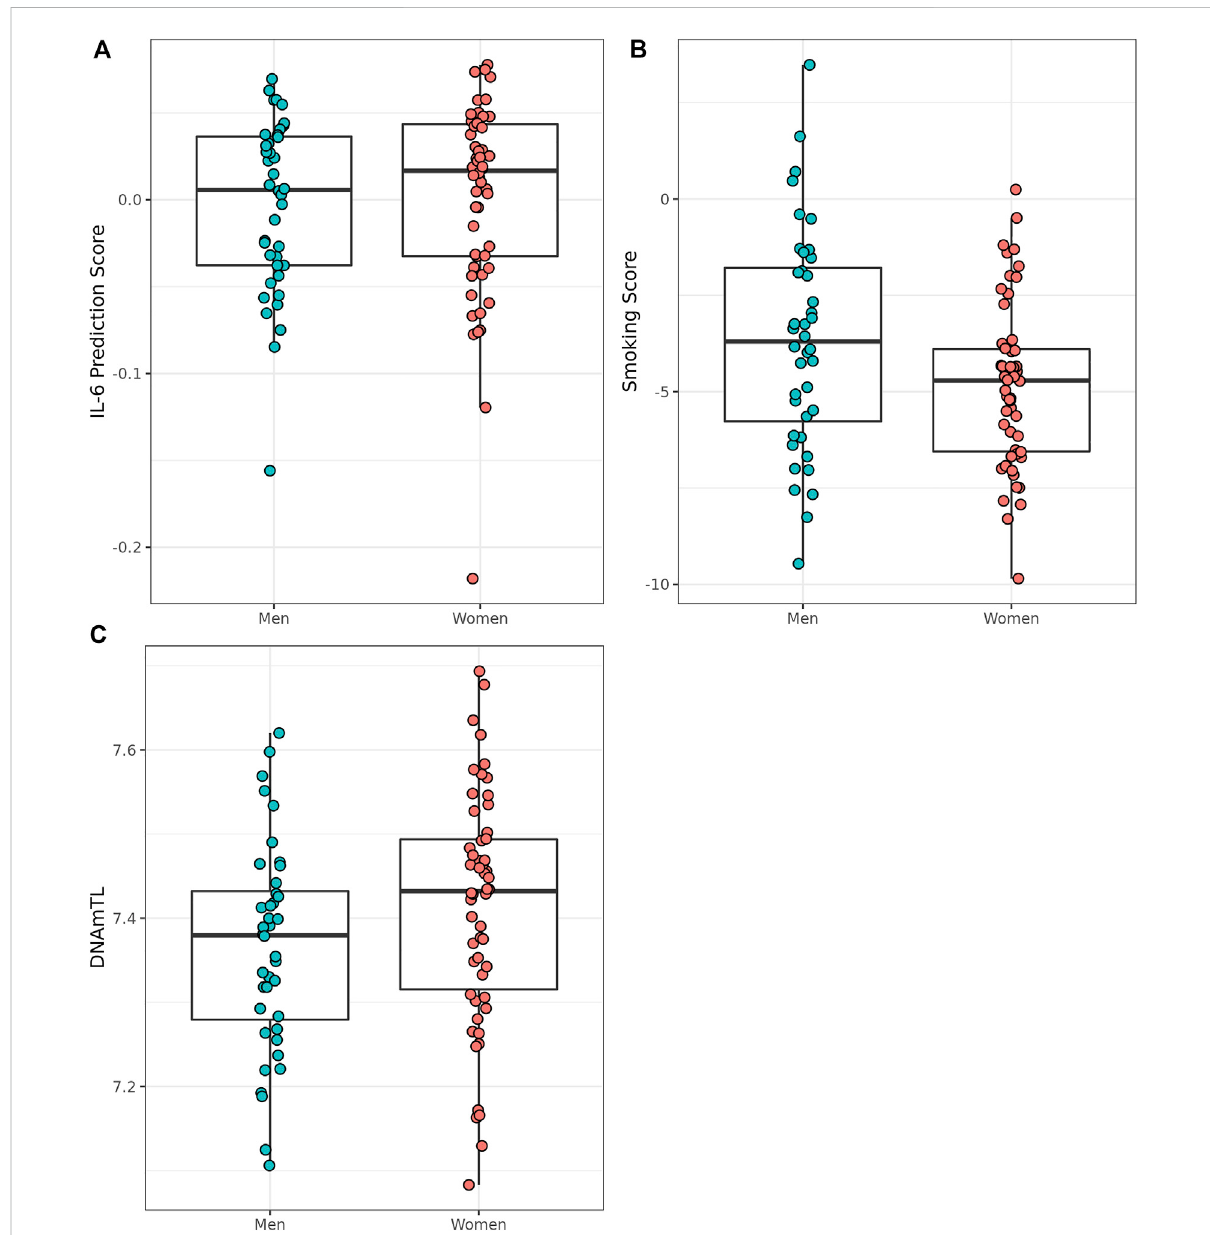
FIGURE 5 Epigenetically predicted biomarkers by sexamongst theoldest oldin theMediterranean Blue Zones, (A) serum IL-6, (B) Smoking Score, and (C) leukocyte telomere length (DNAmTL).